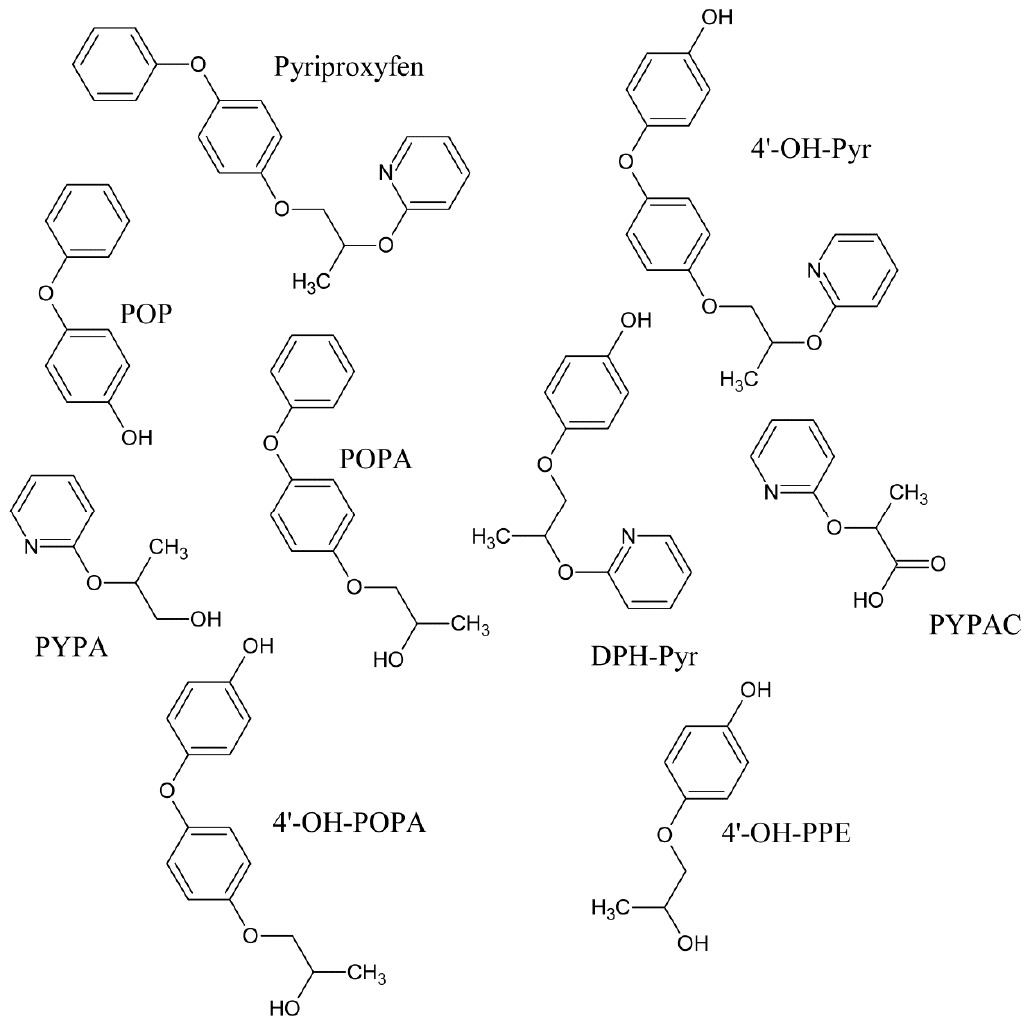
Figure 1. Pyriproxyfen and its main degradation products in soils and plants.